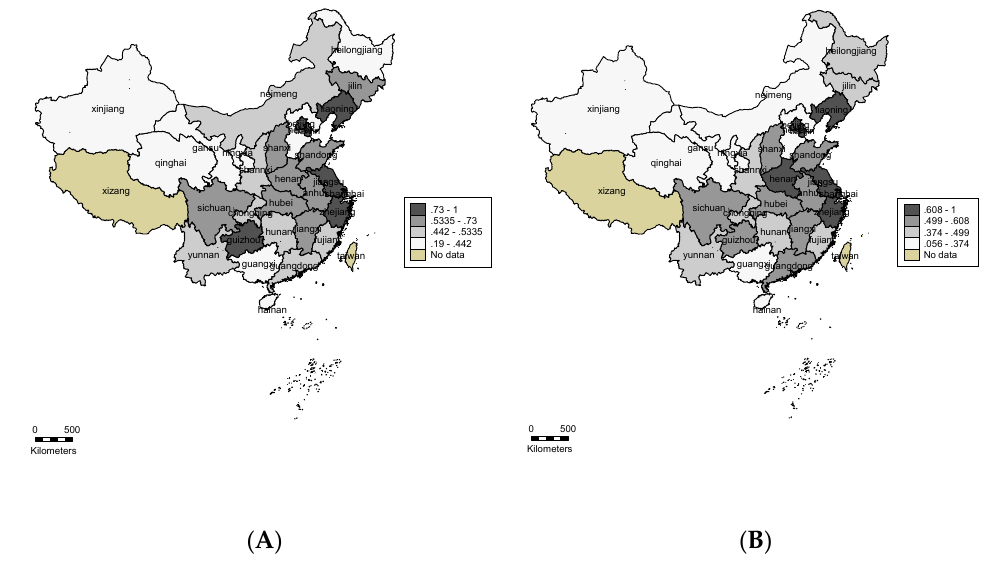
Figure 4. Spatial distribution of eco-efficiency in China’s tourism industry. ( A ) Comprehensive eco-efficiency of the tourism industry. ( B ) Adjusted eco-efficiency of the tourism industry.